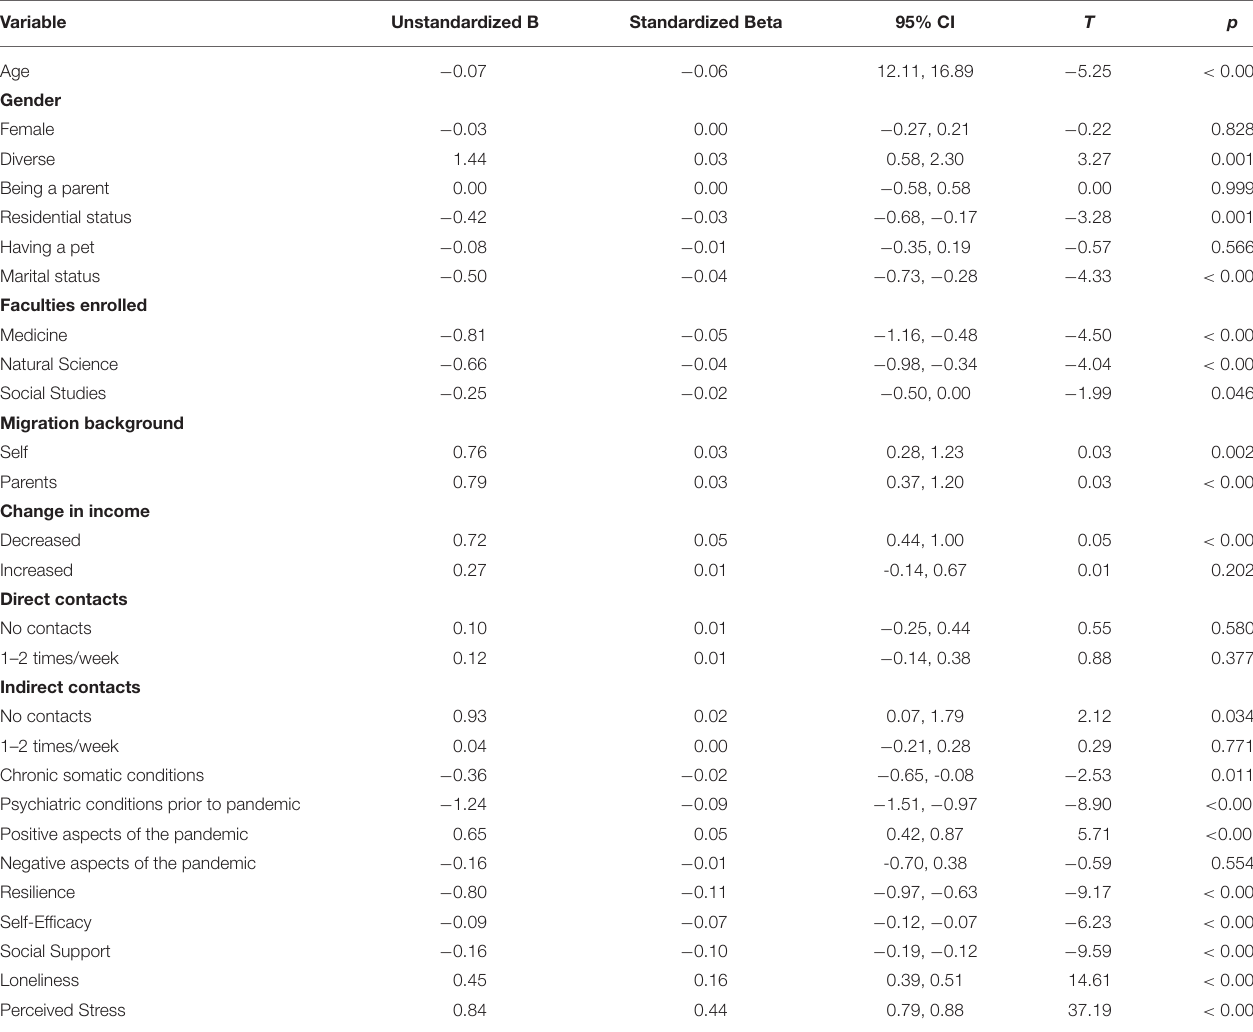
TABLE 3 | Linear regression analysis for predictors of depressive symptomatology measured by PHQ-9 (Patient Health Questionnaire-9).